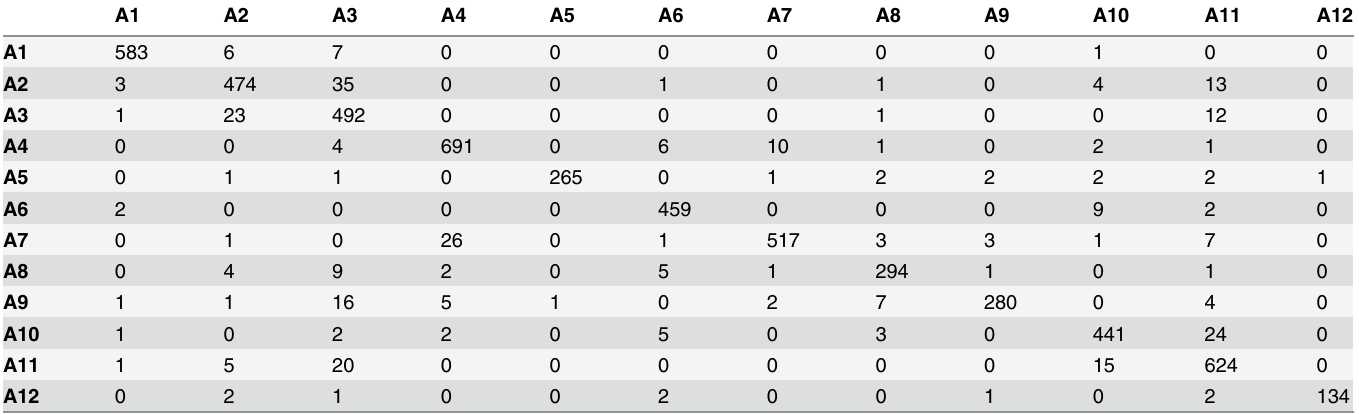
Classification results using acceleration sensor data placed on the ankle Time domain features (FS3) are extracted from the sensor placed on the dominant ankle and the classification results revealed that the rotation forest classifier outperformed the other two classifiers, as shown in Table 6. The KNN classifier failed to distinguish among various physical Table 5. Confusion matrix for rotation forest classifier (Acceleration sensor placed on